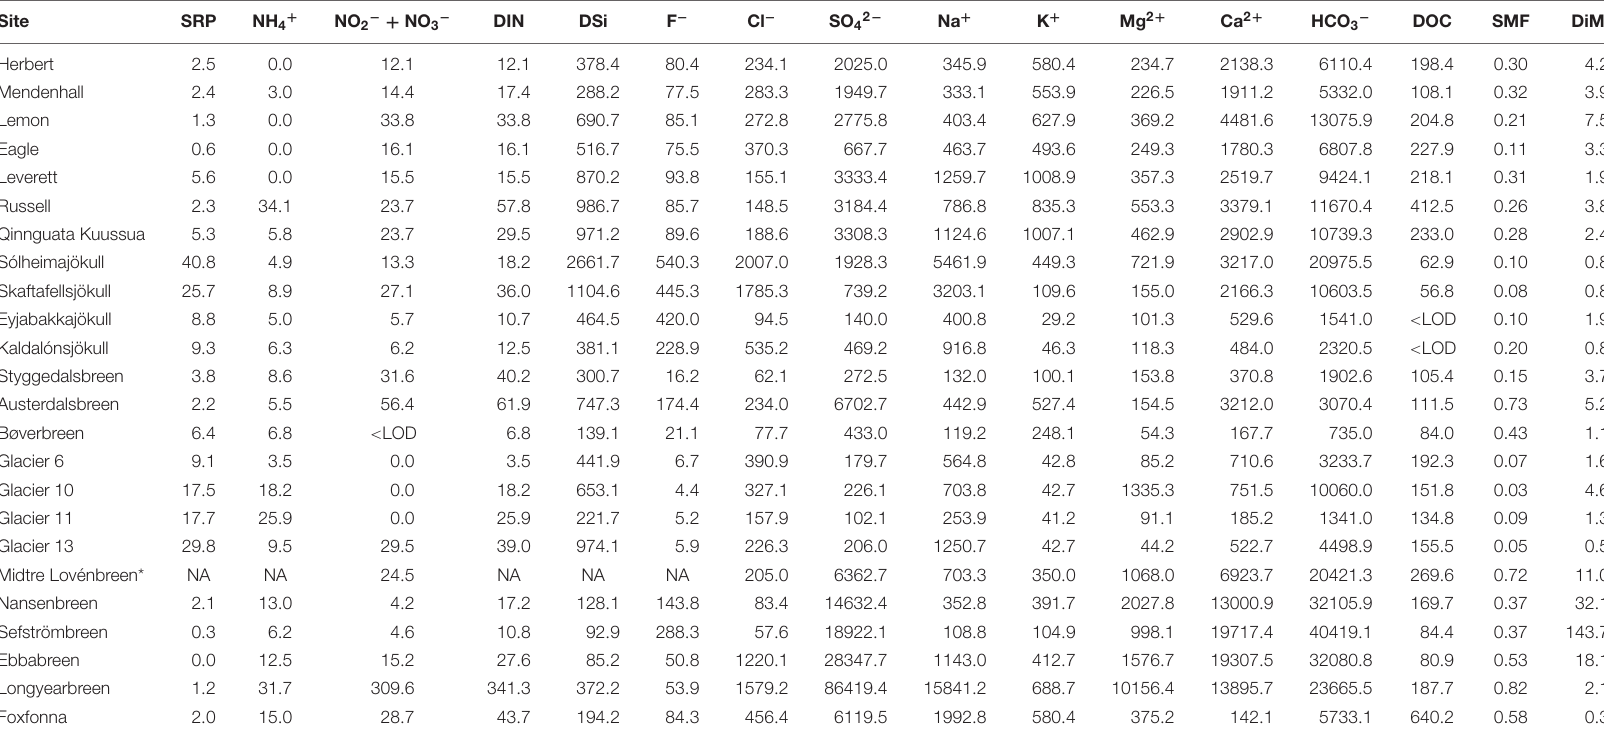
TABLE 2 | Hydrochemical characteristics of meltwater, including nutrient concentrations, major cations and anions, dissolved organic carbon (DOC), sulfate mass fraction (SMF), and the divalent: monovalent ratio (DiMo). Site